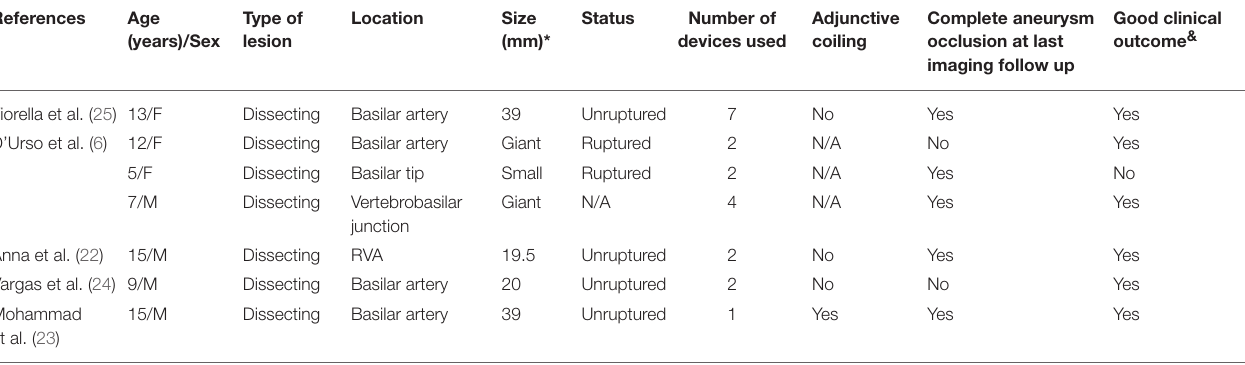
TABLE 3 | Literature summary of the use of the PED technique for pediatric vertebrobasilar dissecting